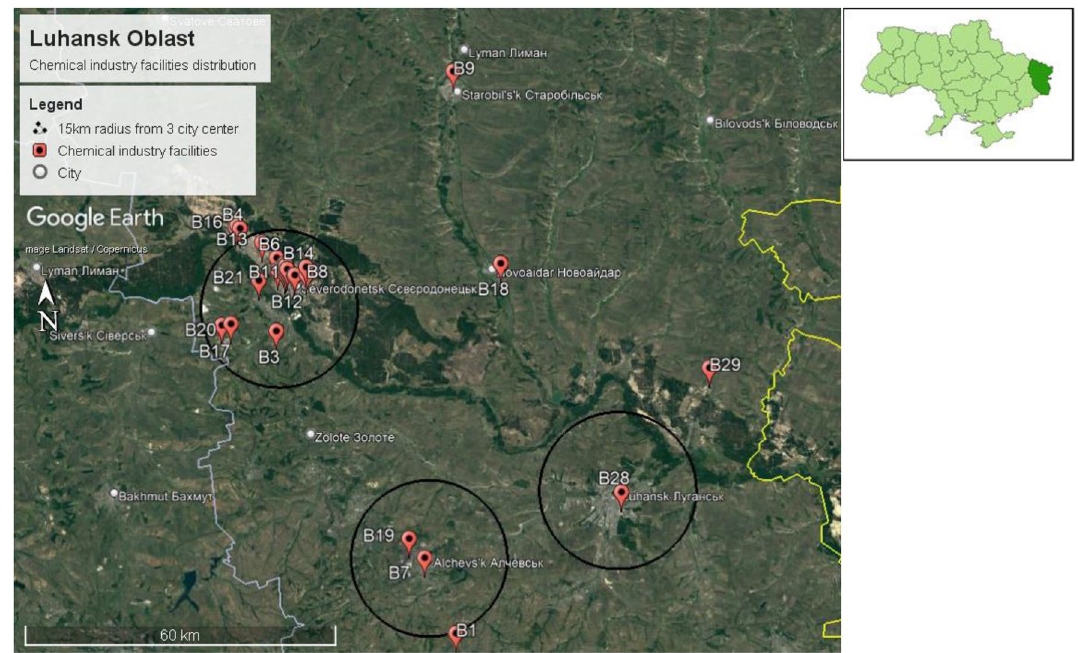
Figure 13. Chemical facilities identified within a 15 km radius of Luhansk city center, Alchevsk city center, and Lysychansk city center.